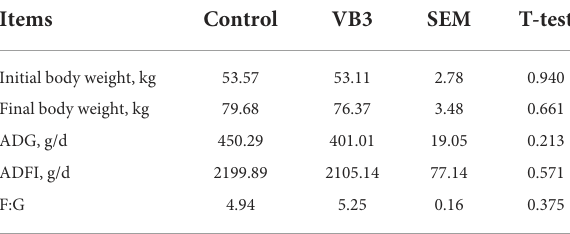
TABLE 1 Basic diet composition and nutritional level of Ningxiang pigs, as-fed basis.